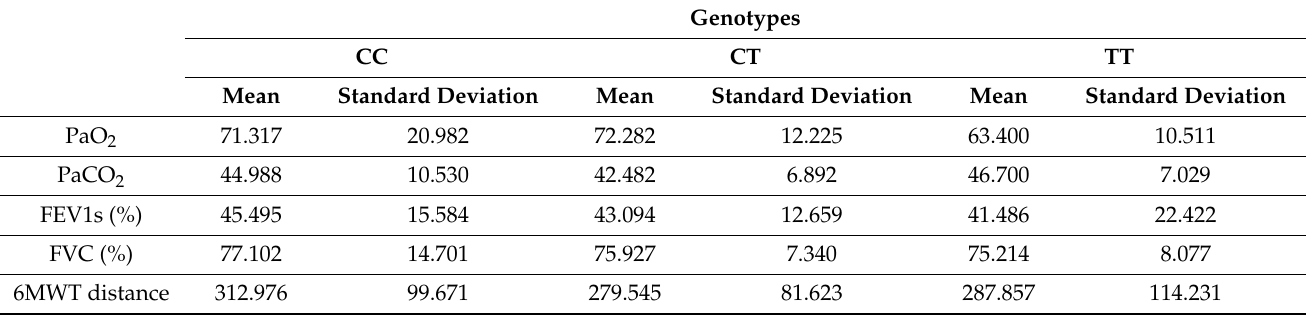
Table 5. Impact of CC, CT, and TT genotypes of VEGF rs3025039 polymorphism on paraclinical prognostic and follow-up